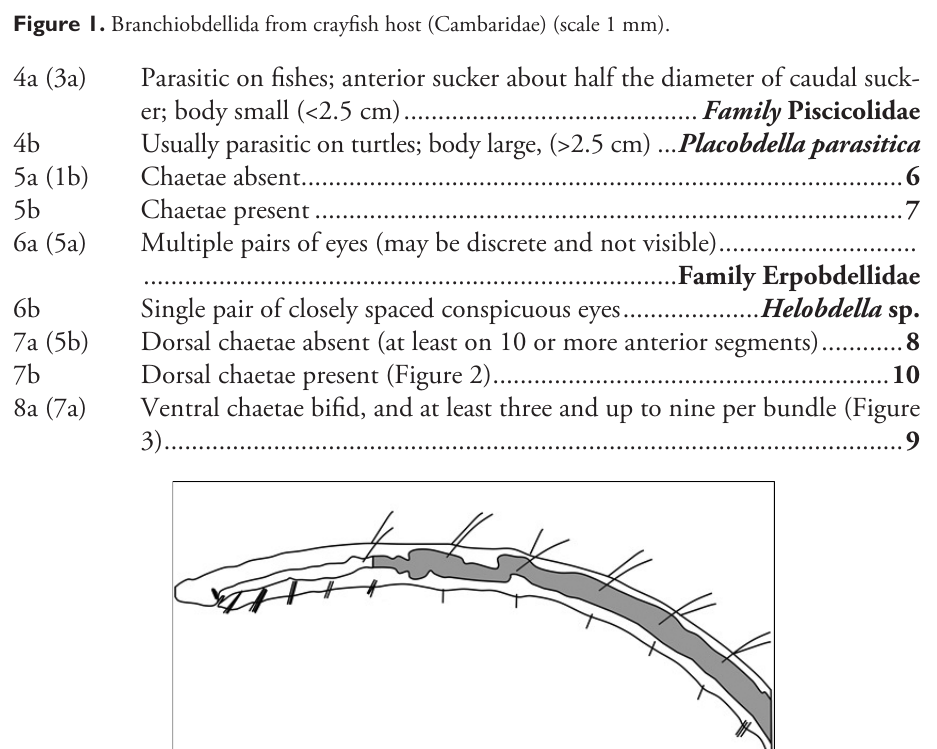
Figure 2. Drawing of generalized aquatic oligochaete showing anterior end and example positions of dorsal and ventral chaetae.